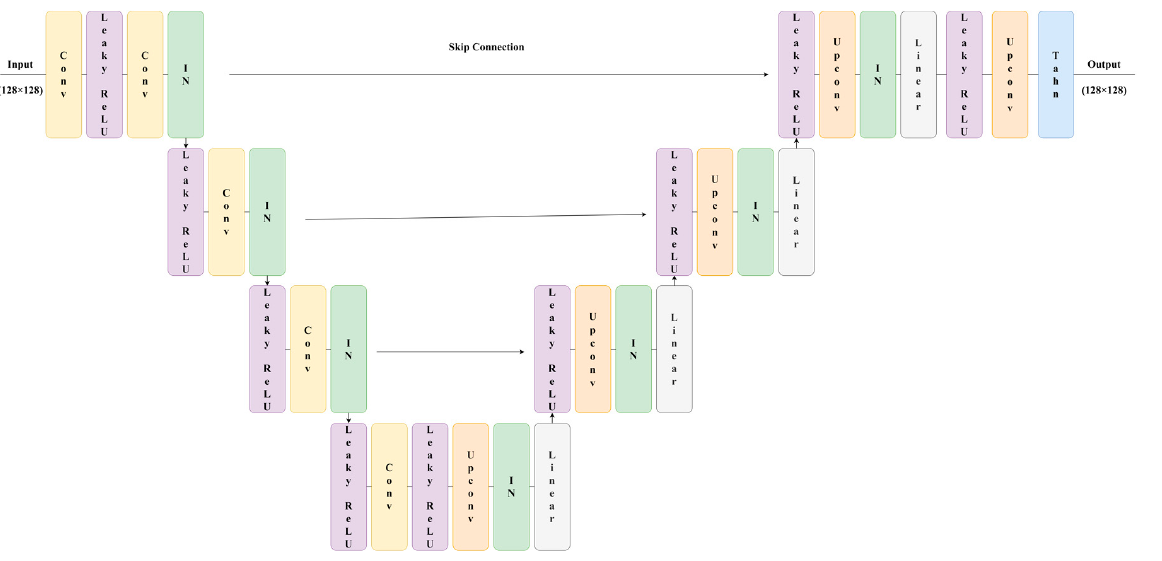
Figure 2. The architecture of the generator.